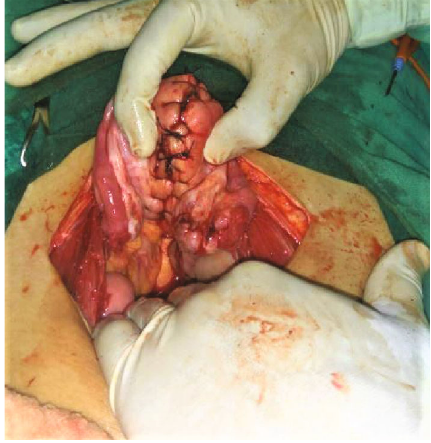
Figure 5: Final view of uterus repair.